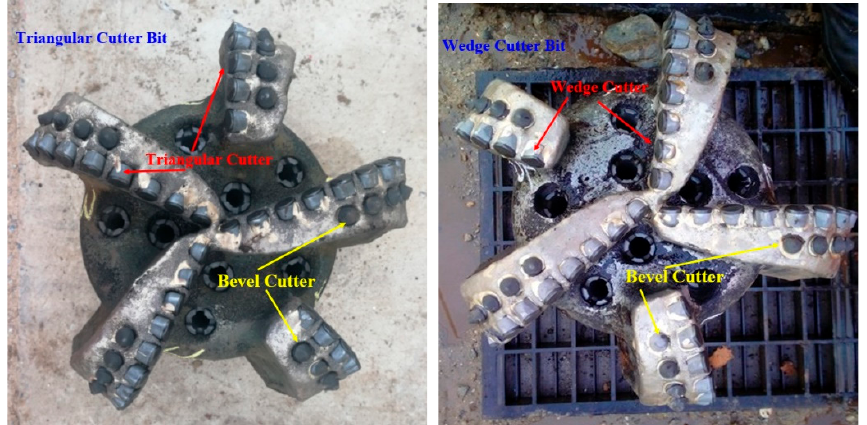
Figure 9. The photo of the field test PDC bit after use. On the left is the triangular cutter bit, on the right is the wedge cutter bit.